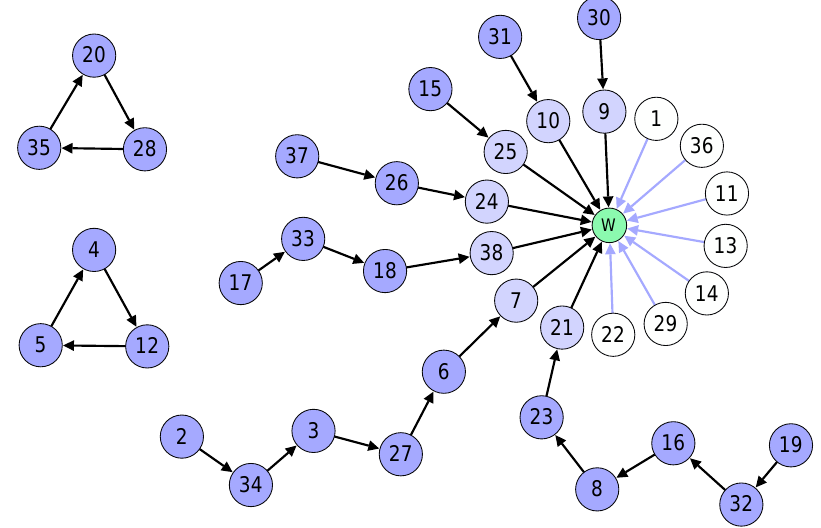
Figure 4. Graph model for the Top Trading Cycles and Chains algorithm. The node W represents the waiting list option. The priority ordering is based on time spent on the waiting